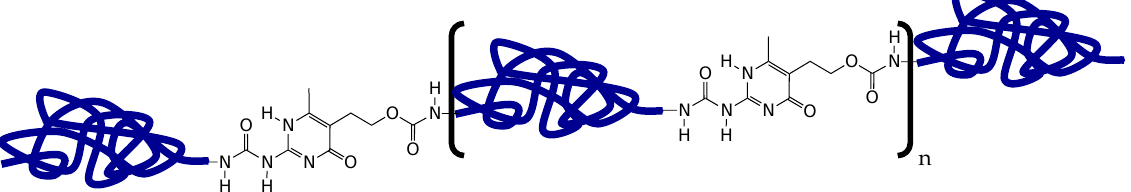
Figure 1. Schematic representation of the UPy-elastomers; in polymer UPy1, the blue line depicts the hydrogenated polybutadiene backbone extended with 4′ -methylenebis(cyclohexyl isocyanate), and in polymer UPy2, the blue line depicts the poly(tetramethylene oxide) backbone extended with isophorone diisocyanate.